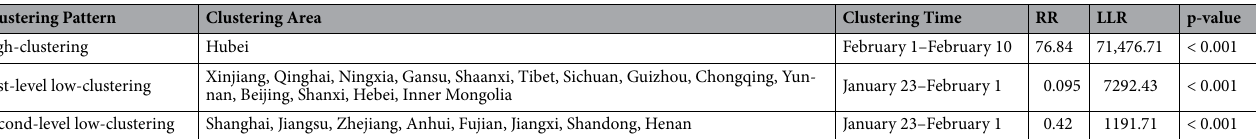
Table 2. The spatio-temporal scanning aggregation results of the new diagnosed cases of COVID-19, January 23–February 11.